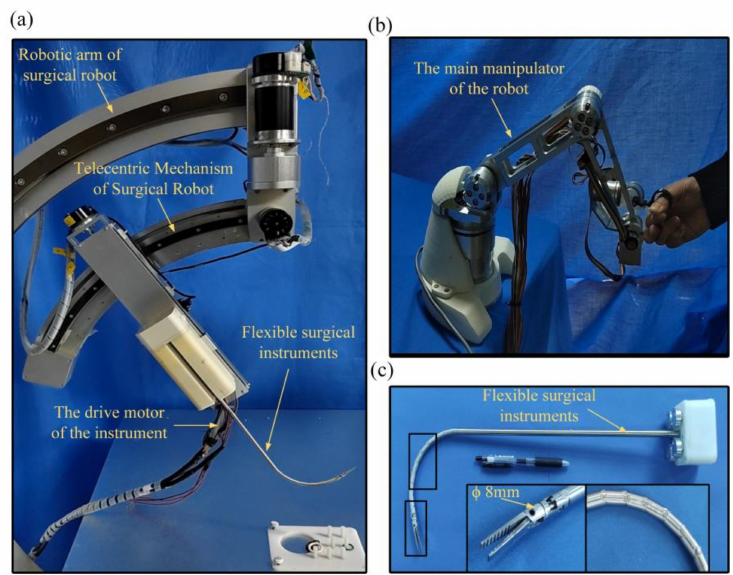
Figure 6. The prototype of the developed flexible surgical instrument: ( a ) minimally invasive surgical robot system; ( b ) the main manipulator of the robot; ( c ) flexible surgical